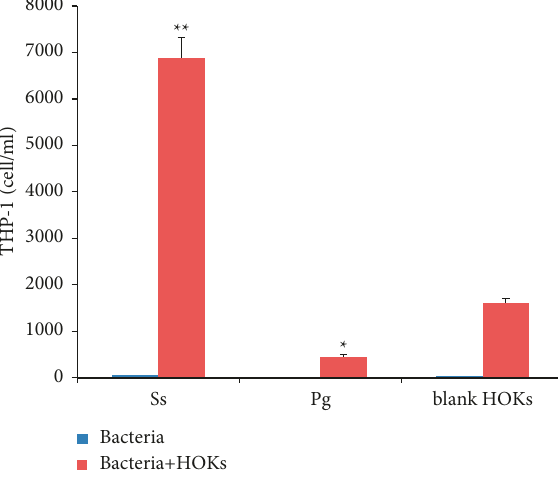
Figure 3: The number of THP-1 cells at 2h attracted to the lower compartment of the transwell apparatus by bacteria alone, or the HOKs challenged by S . sanguinis (Ss) or P . gingivalis (Pg) for 2h. Controls: blank (light blue) and HOK alone (yellow). The results are obtained from three independent assays. Significant difference from the control group, ∗ p < 0 . 01.